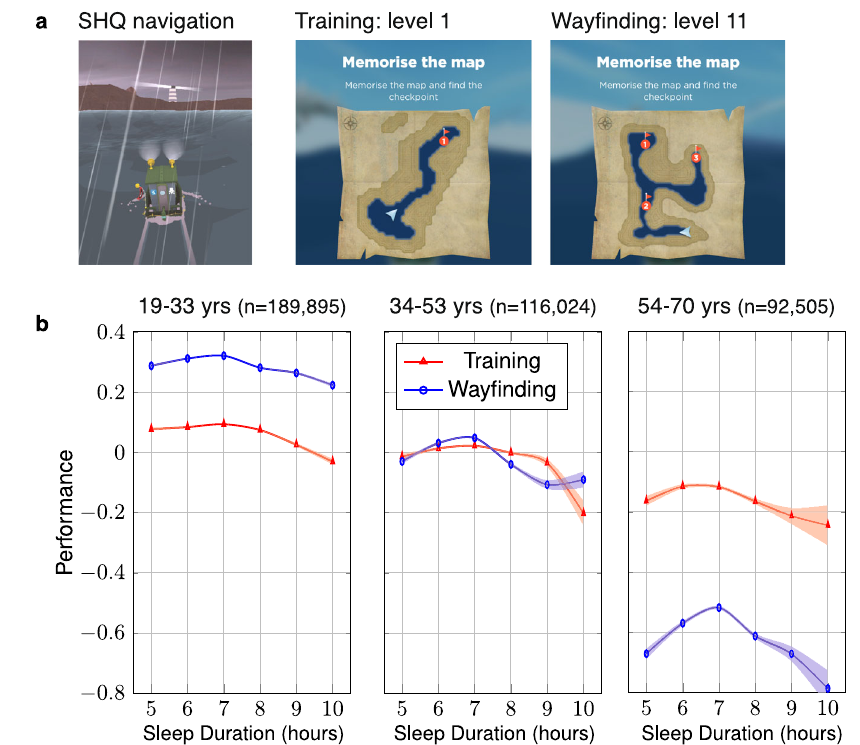
Fig.2|Associationbetweenreportedsleepdurationandspatialabilityinthe3 identi fi edagegroups.a Way fi ndingtask:spatialabilitywasquanti fi edwiththeSea HeroQuest(SHQ)app.Participantscompleted2traininglevelsthatdidnotrequire spatialability,asthetargetwasvisiblefromthestartingpoint.Theyalsocompleted 4 way fi nding levels, where the participants were asked to memorize a map, and